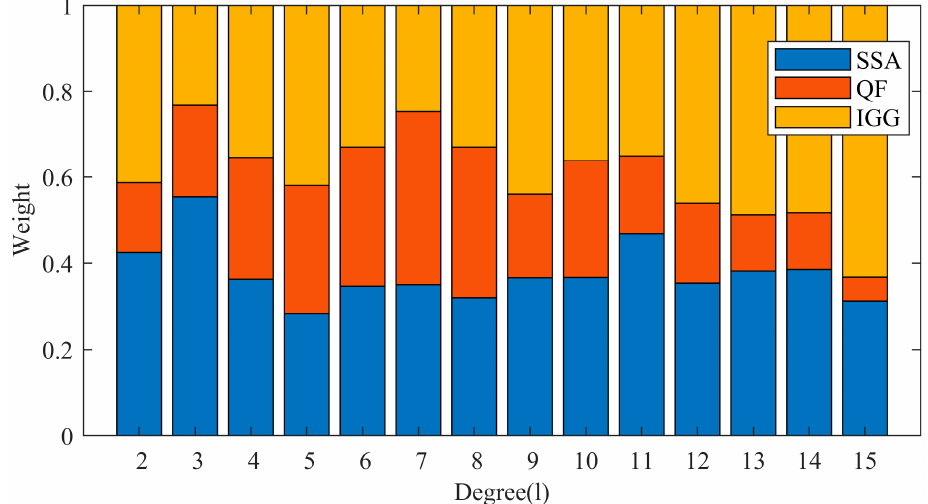
Figure 11. Distribution of weight values for fusing the three SHC datasets used in this study.